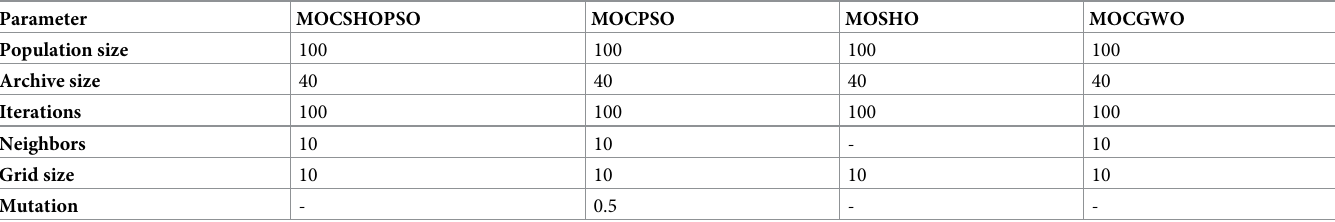
Table 2. Parameter settings of different